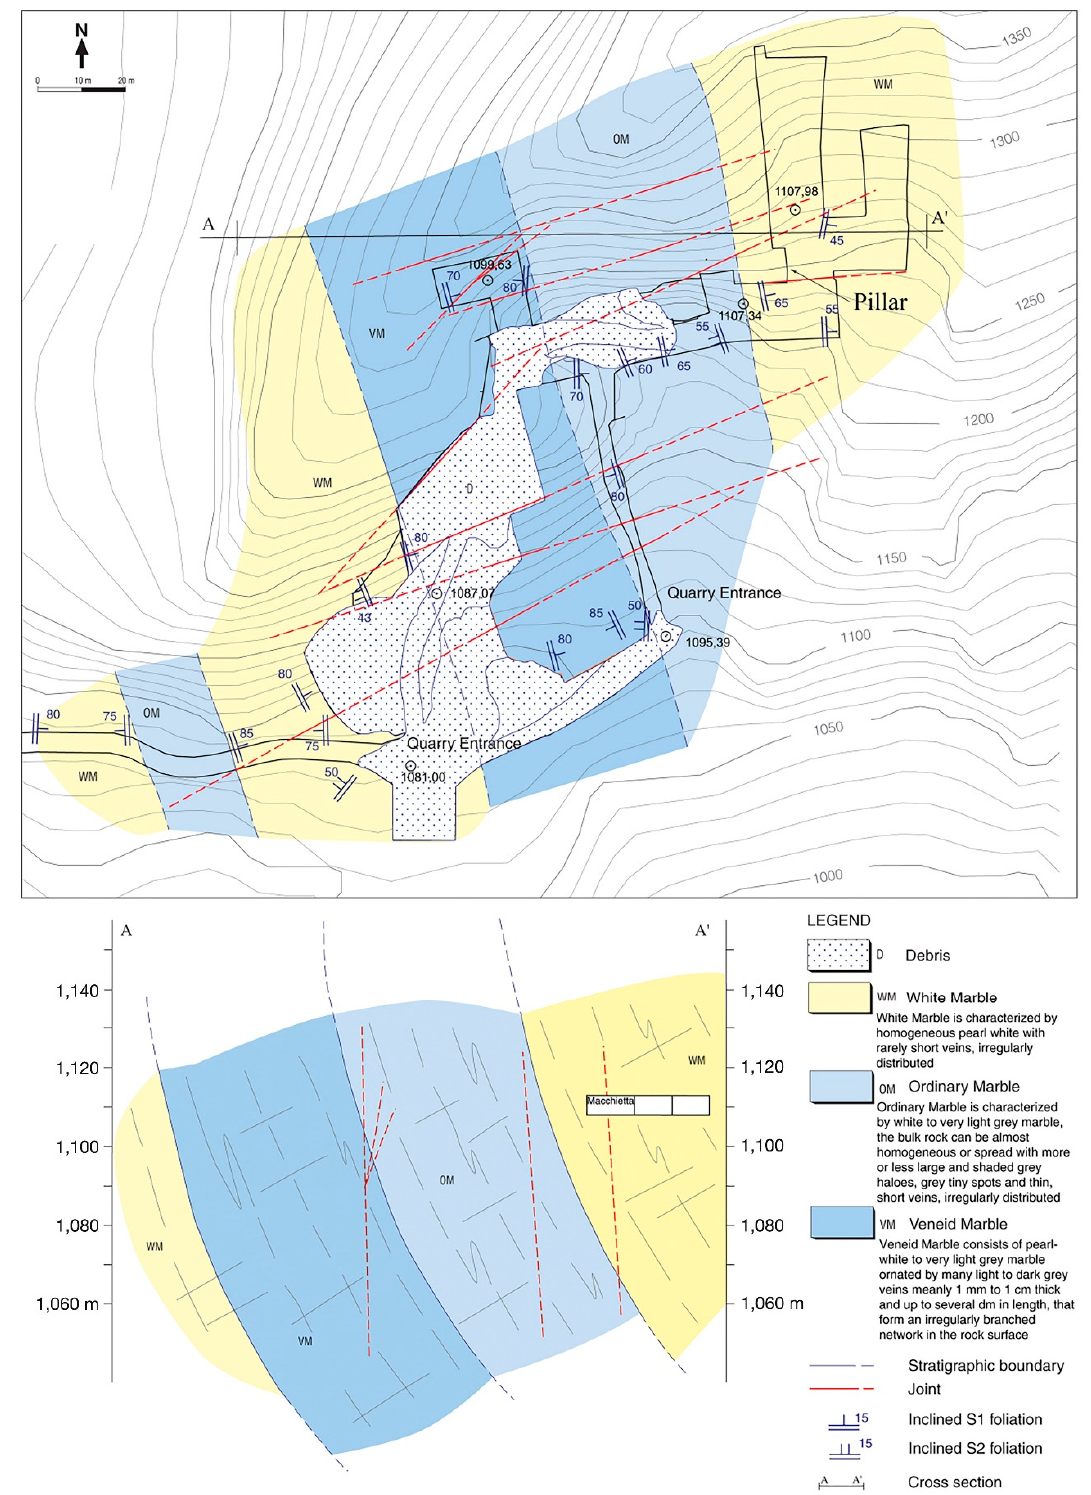
Figure 3. Geological map and geological cross-section (AA’) of the Macchietta quarry with the distribution of joint and marble types.